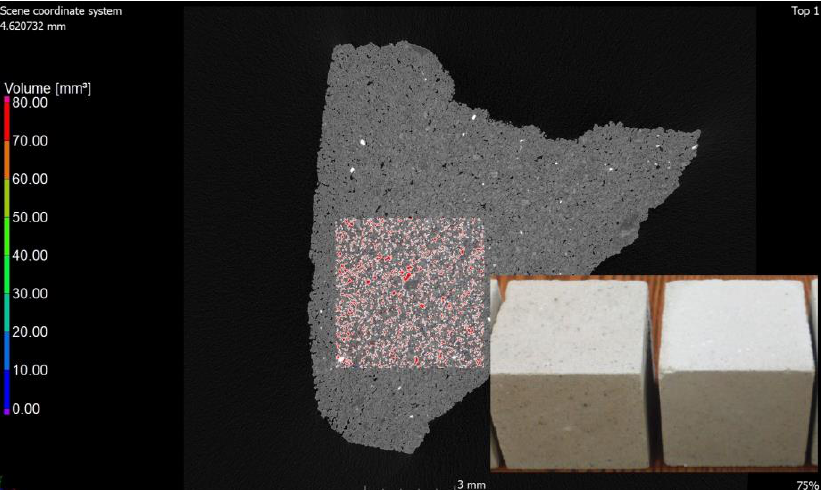
Figure 10. Photo of silicate brick modified with glass sand (GS) with an image of made bricks (dimensions 5 × 5 × 5 cm).